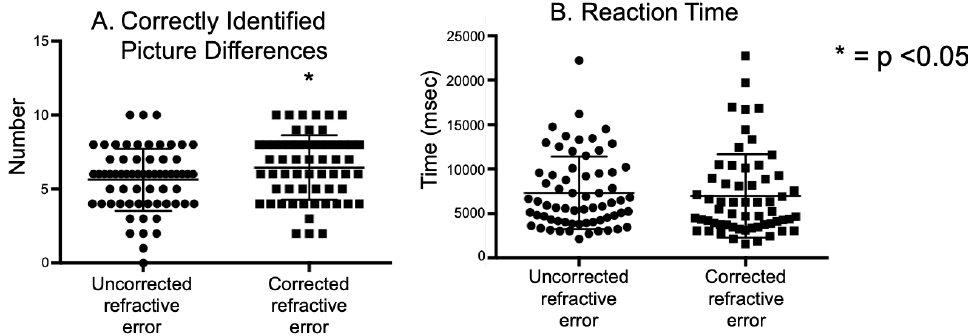
Figure 2. Scatter plot with mean and standard deviation of correctly identified picture differences (A) and reaction time to the first click (B) with uncorrected refractive error (circles) vs. corrected refractive error (squares) condi- tion. Each point represents one trial (total of 5 trials/subject in uncorrected and 5 trials/subject in corrected state). Subjects correctly identified more differences with corrected refractive error. There were no significant differences in the reaction